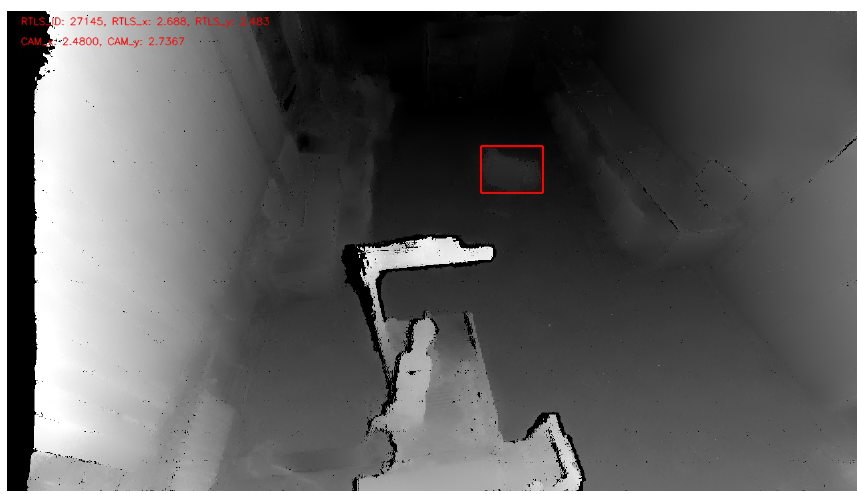
Figure 12. Supply trolley recognition with the help of RTLS and a depth camera. The red rectan- gle represents an identified object based on depth change, and its location is verified against the RTLS